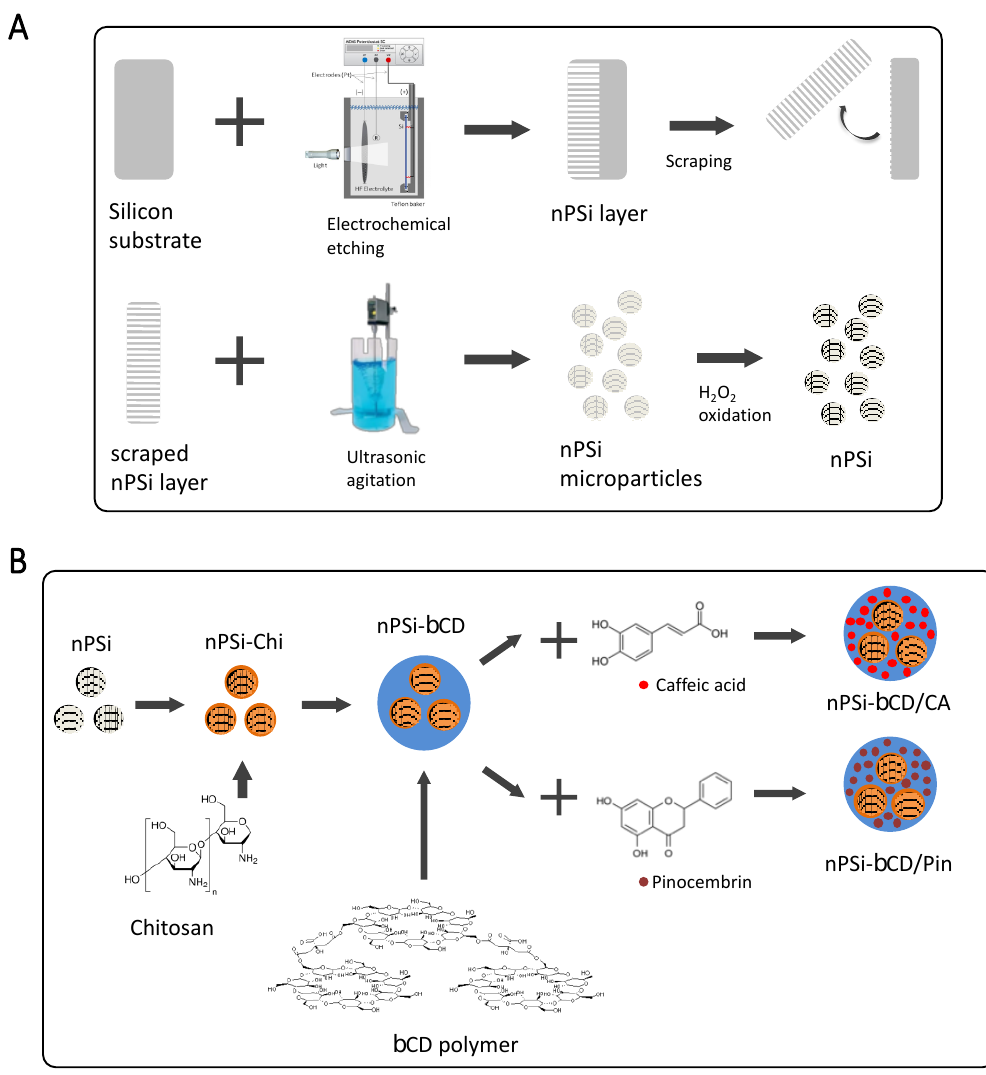
Figure 1. Experimental scheme for the synthesis of: ( A ) nPSi microparticles, and ( B ) nPSi-βCD composite microparticles. nPSi: nanoporous silicon, βCD: β-ciclodextrin polymer.